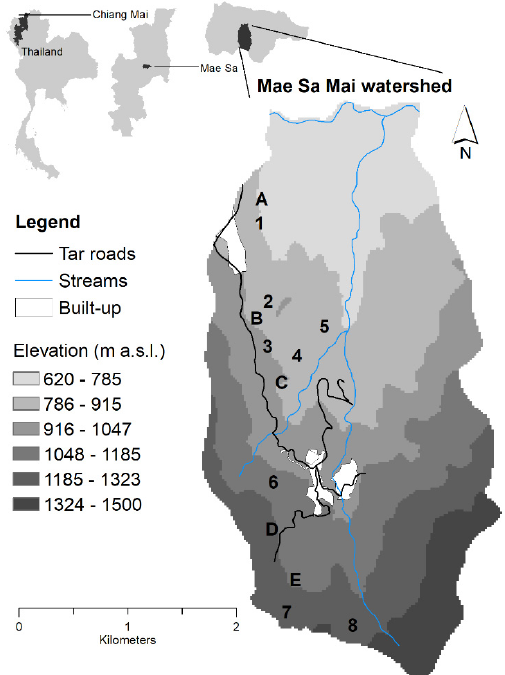
Figure 1. Location of Mae Sai Mai watershed (MSMW) in Chiang Mai province, Northern Thailand, indicating topographic and infrastructure features, and locations of above-ground biomass field measurements, with 1 to 8 referring to litchi orchards, A to E cabbage plots (for explanation see also: Supplemental Material S2 and S3).